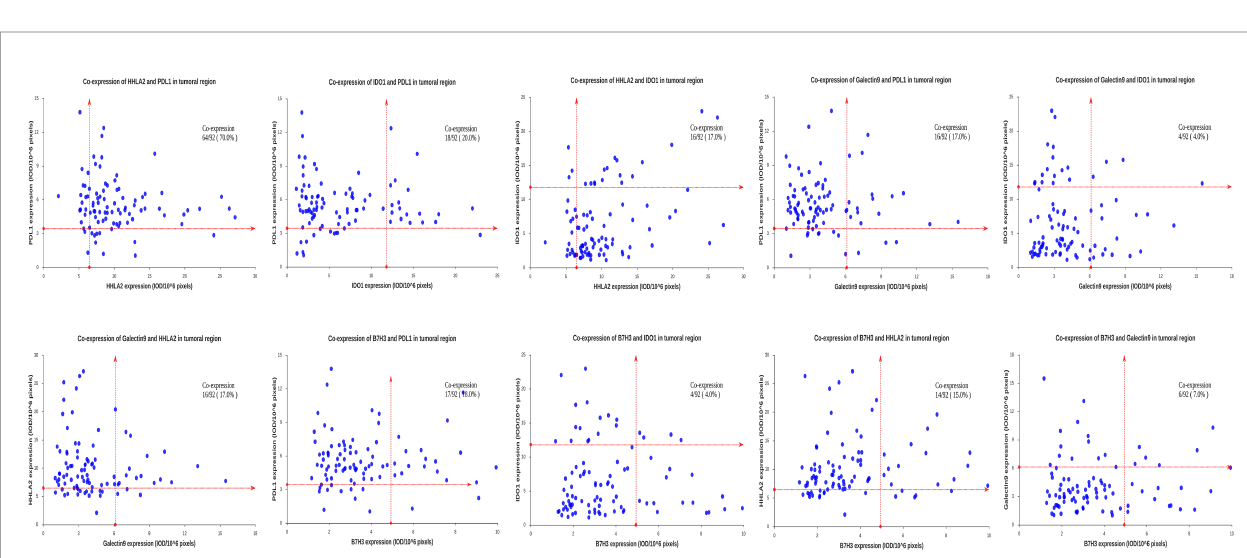
FIGURE 7 | Coexpression of HHLA2, B7H3, IDO-1, PD-L1 and Galectin-9 in the tumor compartment of spinal chordoma samples. Scores are expressed as arbitrary units of fl uorescence, and the dashed red line indicates the signal detection threshold determined as described in the methods section. The proportion of coexpressed cases is indicated within each